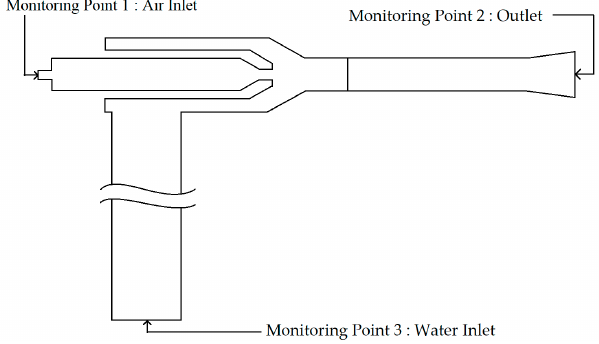
Figure 10. Monitoring points in the computational domain.